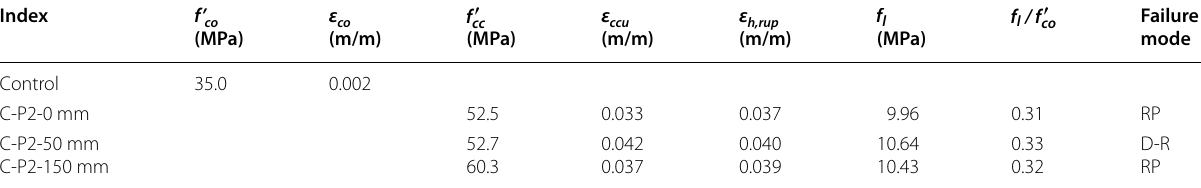
Table 7 Summary of Additional confinement test results: PEN FRP confinement.